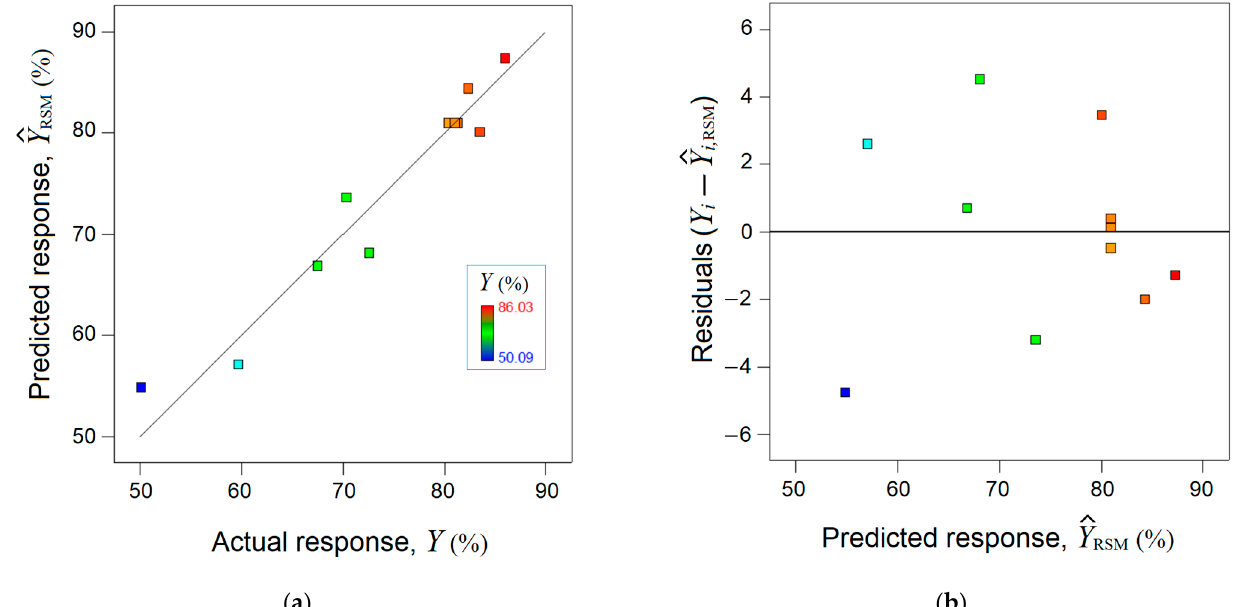
Figure 2. Agreement between experimental data and RSM model: ( a ) Predicted response by RSM vs. actual response, ( r 2 = 0.939); ( b ) residual errors against predicted response ( ˆ Y RSM )